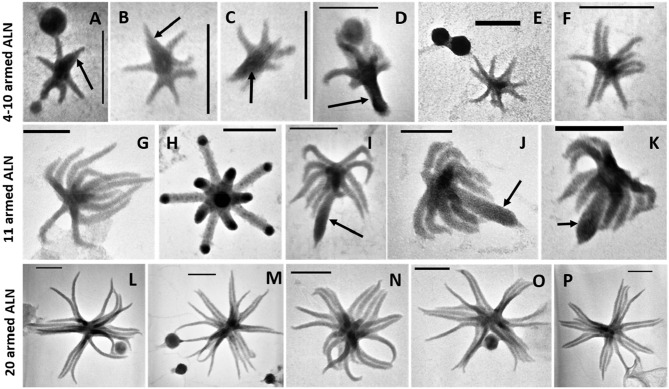
Transmission electron microscopy (TEM) micrographs of different morphotypes of aster-like nanoparticles (ALNs). (A–F) 4–10-armed forms with some (A–D) presenting a few arms articulated around a delta-shaped excrescence (arrows). (G–K) 11-armed forms and their budding 11-armed variants (I–K) with elongated and swollen bud-like excrescences (arrows). (L–P) 20-armed forms. Scale bars = 100 nm.